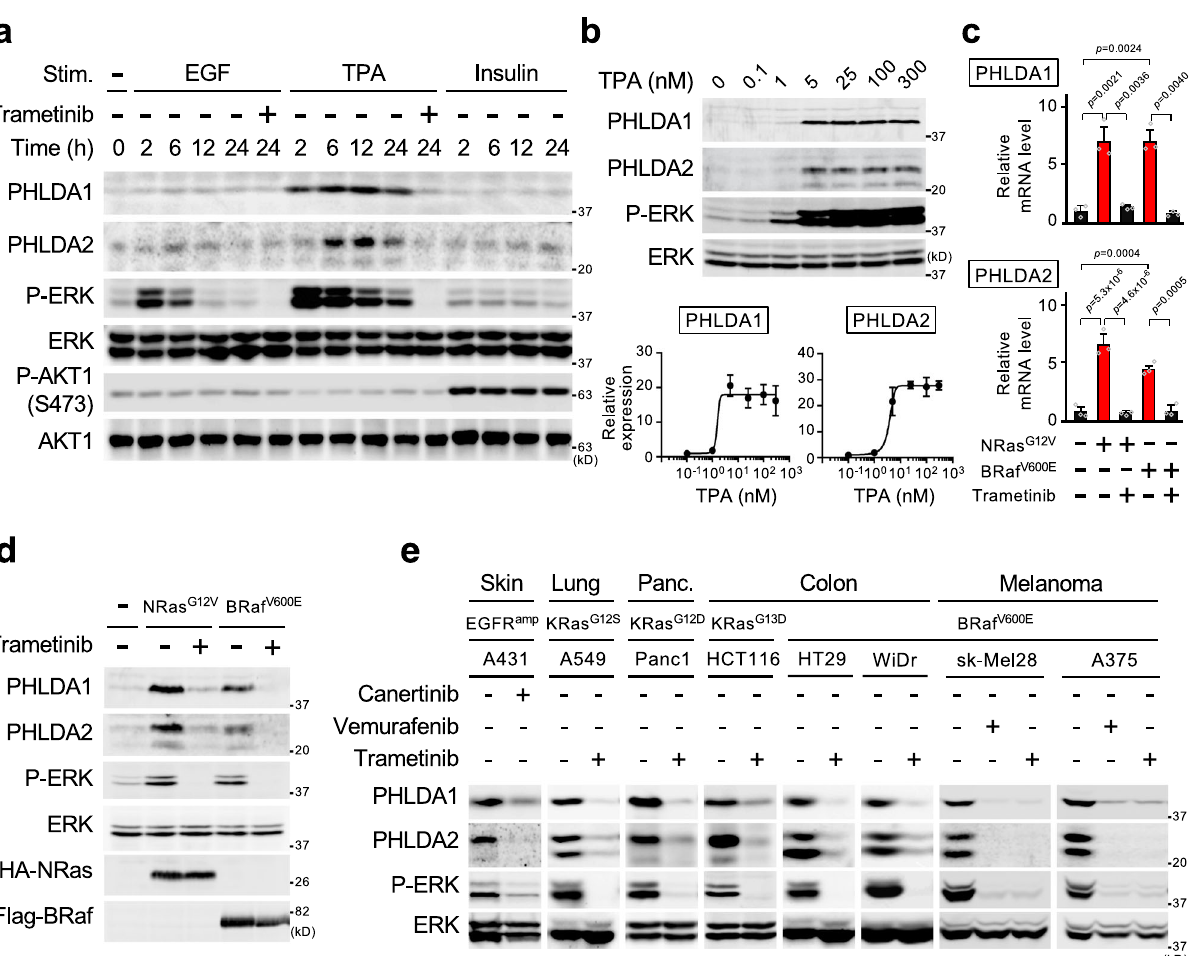
Fig. 7 PHLDA1/2 are highly expressed in cancers harboring ERK activating oncogenes. a Oncogenic ERK signaling induces simultaneous PHLDA1/2 expression. HEK293 cells were stimulated with EGF, TPA, or insulin with or without trametinib for the indicated times. The cell lysates were probed for PHLDA1/2 expression, and for the phosphorylation states and protein levels of ERK and AKT by immunoblotting. b HEK293 cells were treated with various concentration of TPA for 6 h, and the cell lysates were analyzed as in ( a ). The intensity of the PHLDA1/2 bands was quanti fi ed (bottom graphs). c , d PHLDA1/2 mRNA and protein expression levels in HEK293 cells stably expressing NRas G12V or BRaf V600E were assessed using qRT-PCR ( c ) and by immunoblotting ( d ), respectively. Where indicated, the cells were pretreated with the MEK inhibitor, trametinib. e Immunoblot analysis of PHLDA1/2 expression in various cancer cell lines harboring the indicated oncogenes. Where indicated, cells were pretreated with the EGFR inhibitor (canertinib), the BRaf inhibitor (vemurafenib), or trametinib. b , c Data are mean ± SEM from three independent experiments. P -values were assessed using one-way ANOVA followed by Tukey ’ s multiple comparisons test. Source data are provided as a Source Data fi